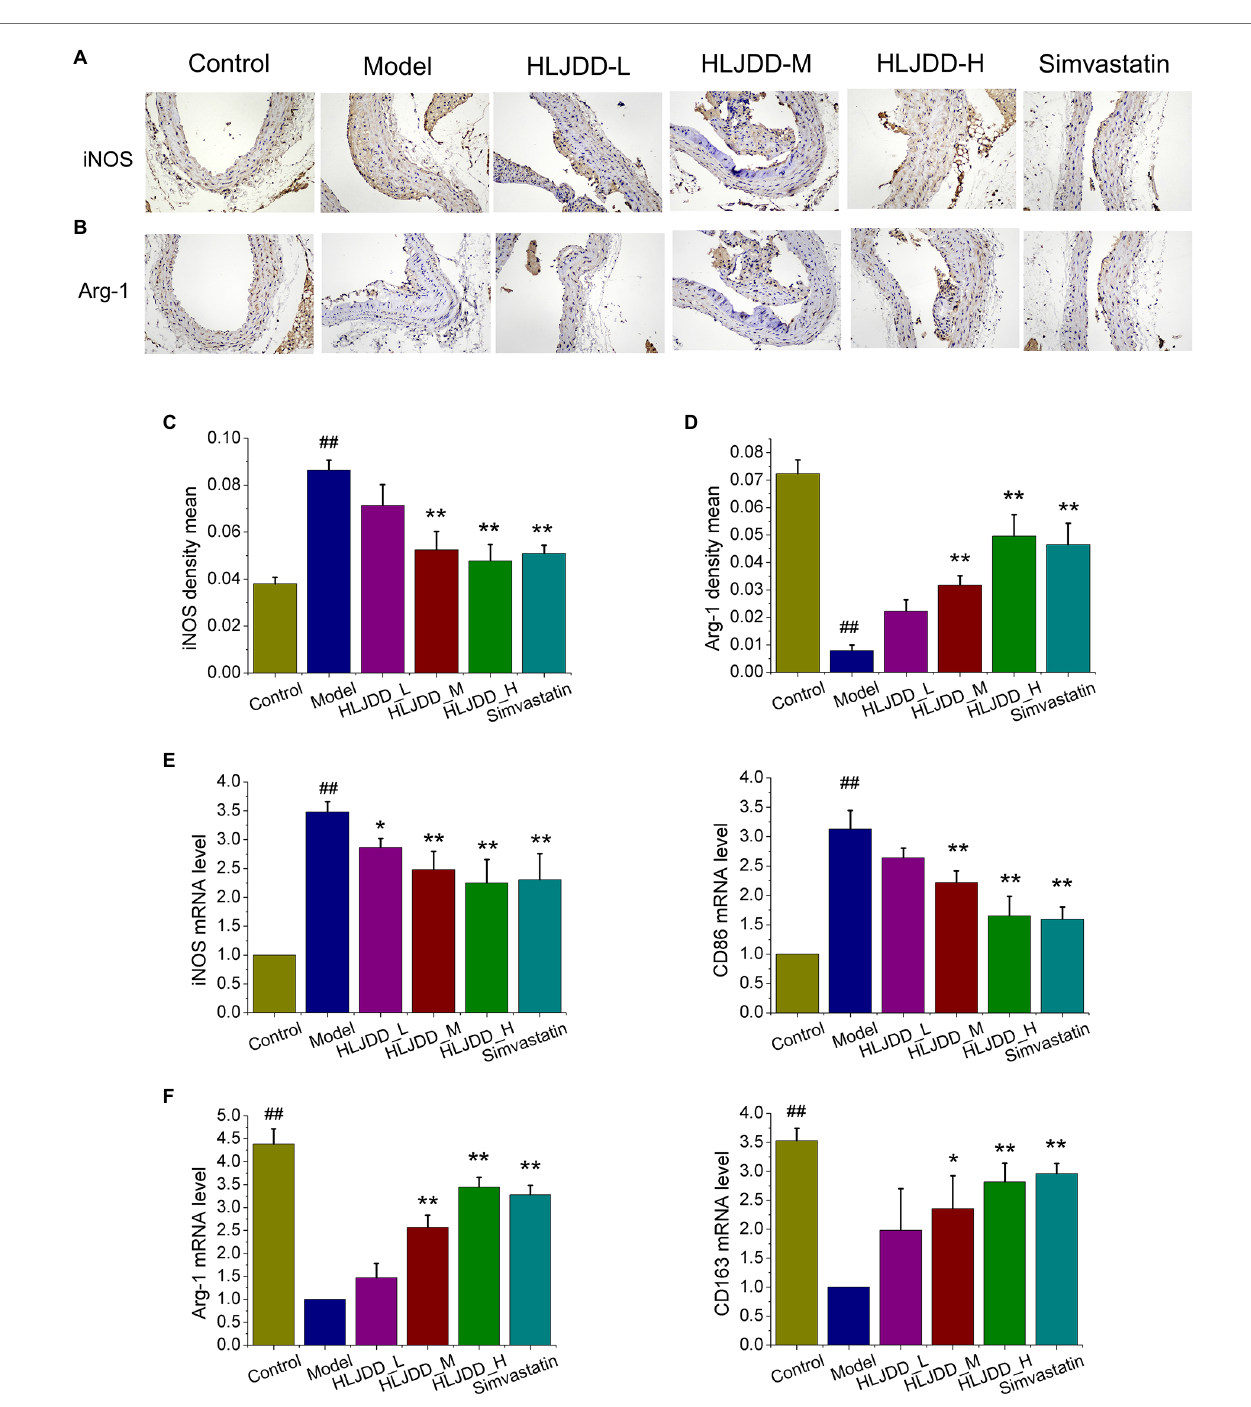
FIGURE 3 | Effects of HLJDD on macrophage polarization in ApoE − / − mice with AS. (A) Representative immunohistochemical staining showed the expression of inducible nitric oxide synthase (iNOS) in carotid sections. Magnification, ×200; scale bar = 200 μ m. (B) Representative immunohistochemical staining showed the expression of Arg-1 in carotid sections. Magnification, ×200; scale bar = 200 μ m. (C) The average optical density of iNOS in carotid sections was semi quantitatively analyzed by Image Pro Plus 6.0 software. Values are expressed as the mean ± SD ( n = 5; ## p < 0.01 vs. the control group; * p < 0.05 and ** p < 0.01 vs. the model group; one-way ANOVA). (D) The average density of Arg-1 in carotid sections was semi quantitatively analyzed by Image Pro Plus 6.0 software. Values are expressed as the mean ± SD ( n = 5; * p < 0.05 and ** p < 0.01 vs. the model group; one-way ANOVA). (E) The mRNA expression of iNOS and CD86 in carotid tissues were detected by real-time PCR (RT-PCR; n = 5; ## p < 0.01 vs. the control group; * p < 0.05 and ** p < 0.01 vs. the control group; one-way ANOVA). (F) The mRNA expression of Arg-1 and CD163 in carotid tissues were detected by RT-PCR. Values are expressed as the mean ± SD ( n = 5; ## p < 0.01 vs. the model group; * p < 0.05 and ** p < 0.01 vs. the model group; one-way